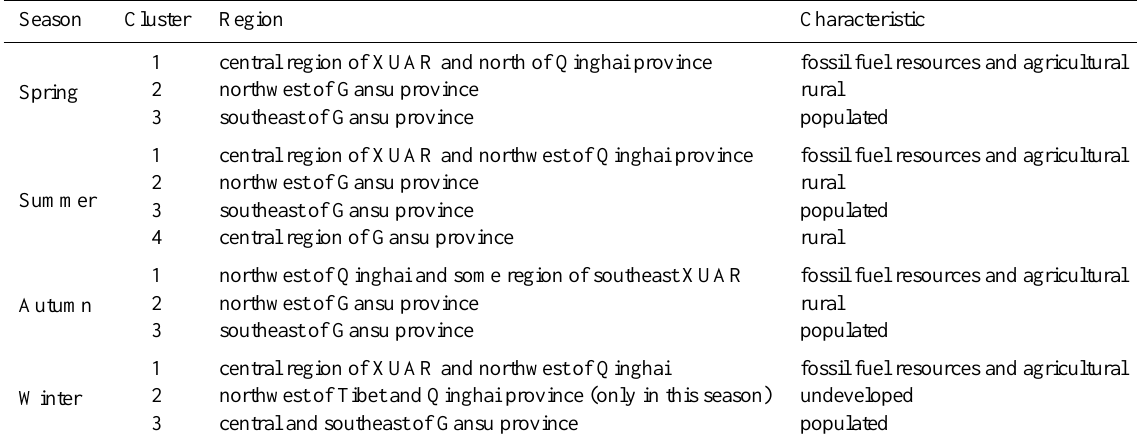
Table 3. Characteristics for each cluster in all